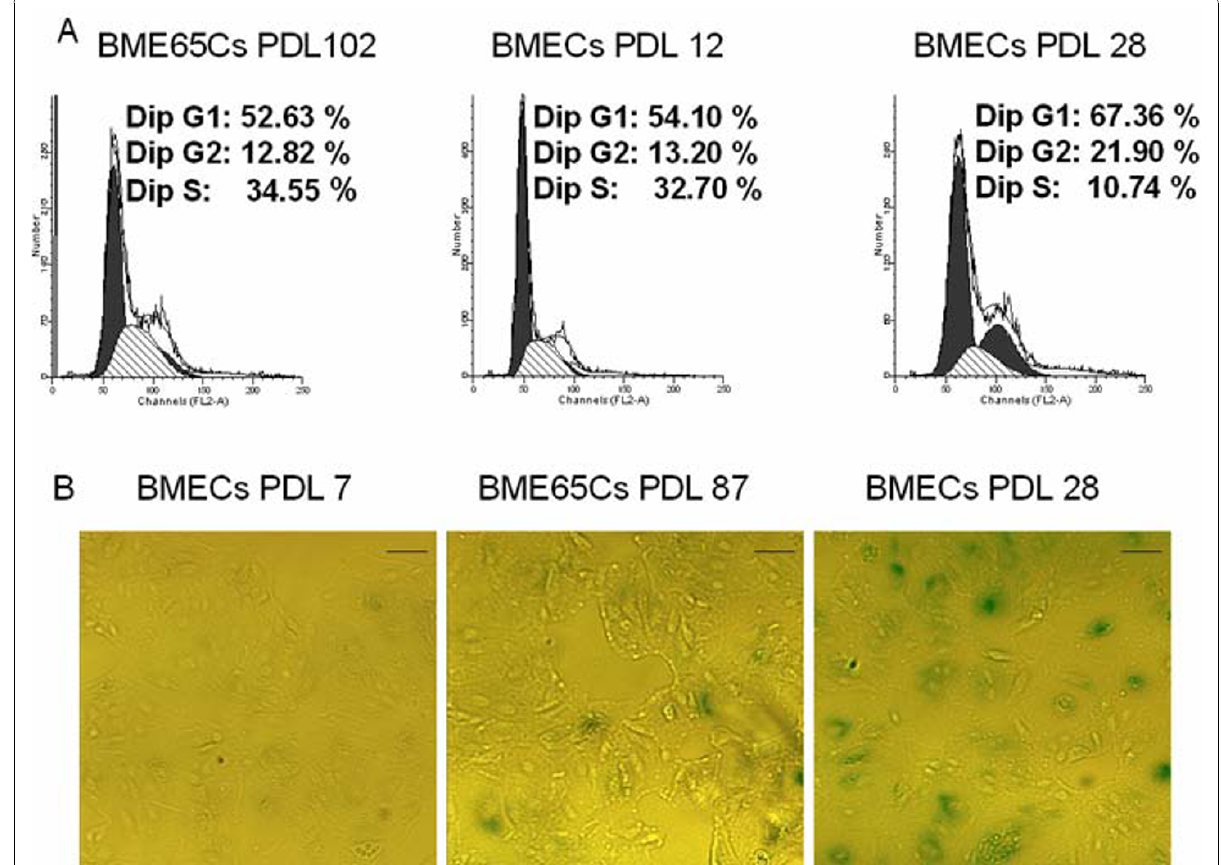
Figure 3 Analysis of cell cycle and cell senescence-associated b -galactosidase activity in BME65Cs and BMECs cells . A . Cell cycle analysis of BME65Cs cells (passage 102), BMECs cells primary passage 12 and 28 was performed using flow cytometry of propidium iodide-stained cells. A similar proportion of cells in S phase were observed in immortalised BME65Cs cells and early passage BMECs cells. B . Early passage 7, BMEC cells senescent passage 28 and immortal BME65Cs cells passage 87 were stained for b -galactosidase activity. Cells were fixed and incubated with X- gal. Blue staining indicates the presence of senescence associated b -galactosidase. This illustrates that a portion of immortalised BME65Cs cells (PDL 87) were in the senescent state. Bars: 20 μ